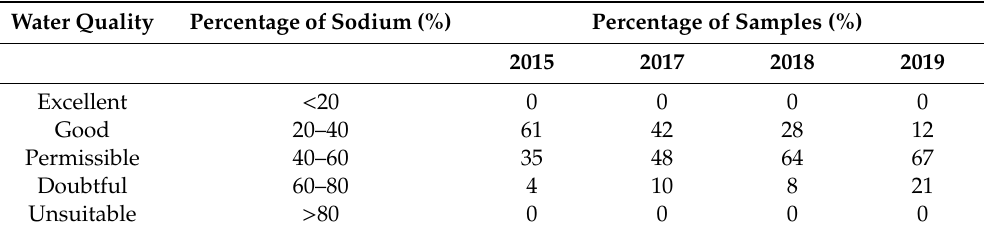
Table 4. Groundwater quality classification based on % Na [46].